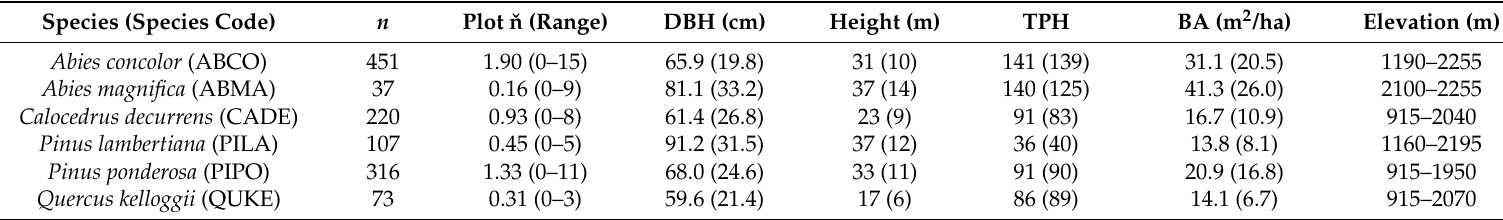
Table 1. The original number of overstory study trees (greater than 25.4 cm in diameter at breast height (DBH)) and the mean (ˇn) number of trees per plot recorded in Spring 2015 (both dead and alive) by species and monitored from 2015 to 2017. Tree measurements include their mean (SD) DBH (cm), height (m), average plot trees per hectare (TPH), average plot basal area per hectare (m 2 /ha; BA), and elevation range recorded (m) across 255 plots within the Dinkey Collaborative Forest Landscape Restoration Project of the Southern Sierra